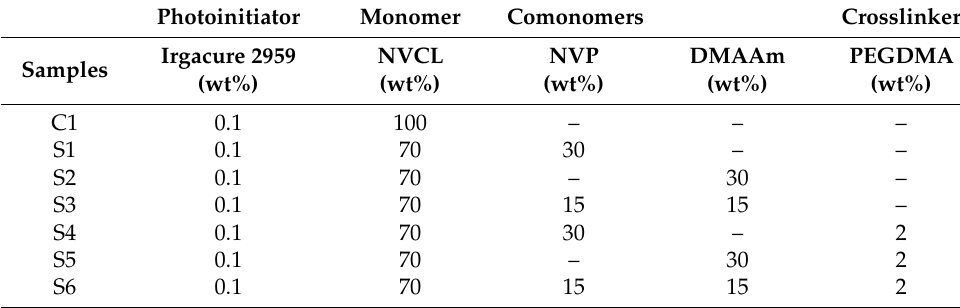
Table 2. Compositions of physically and chemically crosslinked